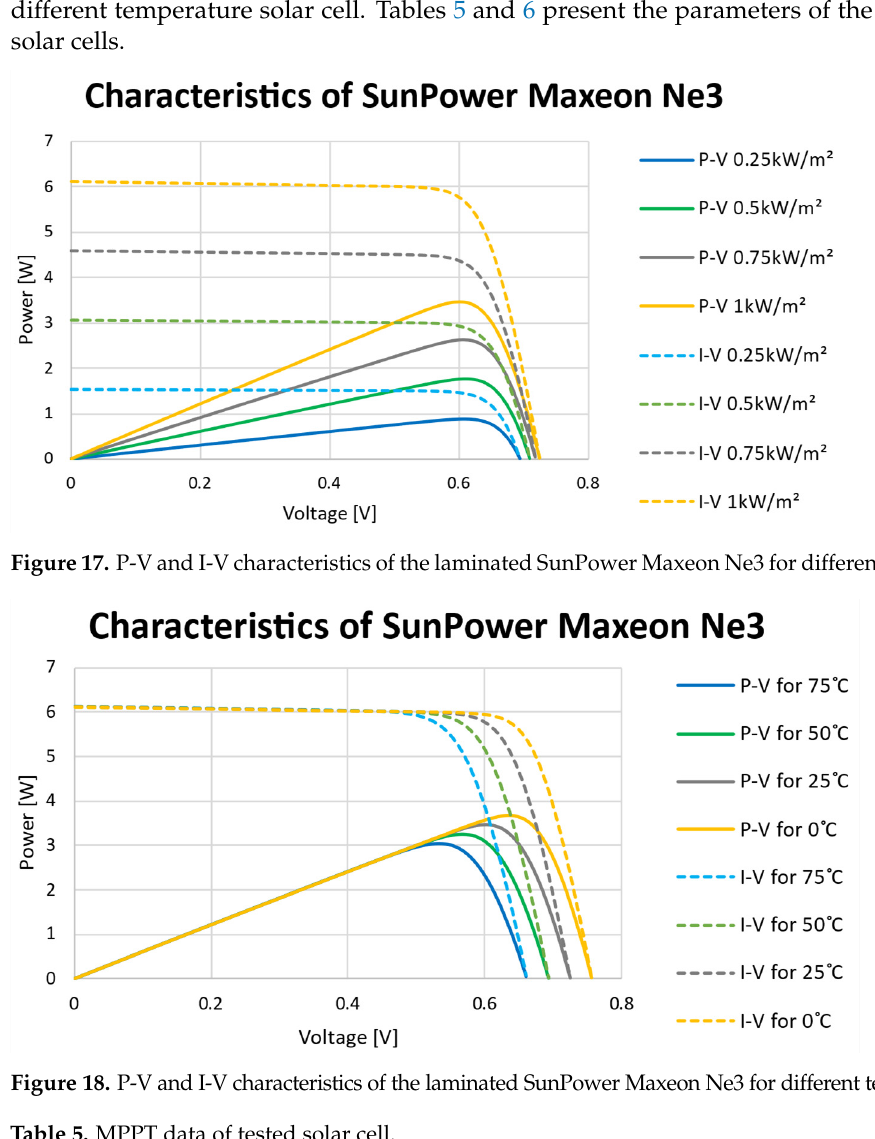
Table 6. MPPT data for tested solar cell in different temperatures.